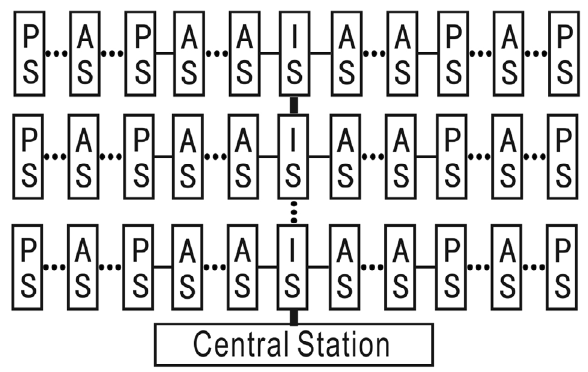
Figure 1. Block diagram of a telemetric digital seismic instrument. PS, power station; AS, acquisition station; IS, interconnection station.